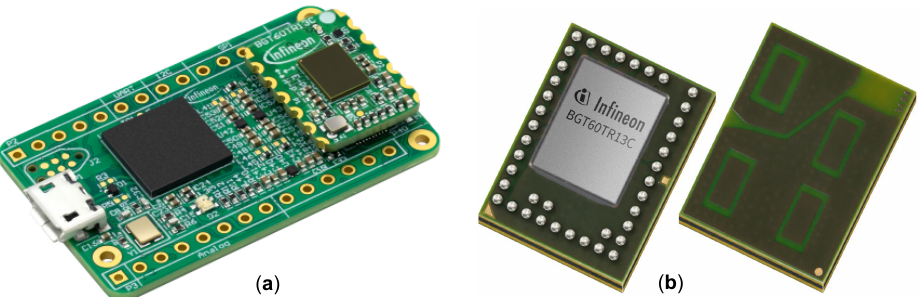
Figure 3. The BGT60TR13 radar system ( a ) delivers filtered, mixed, and digitized information from each Rx channel. The BGT60TR13C radar ( b ) is mounted on top of the evaluation